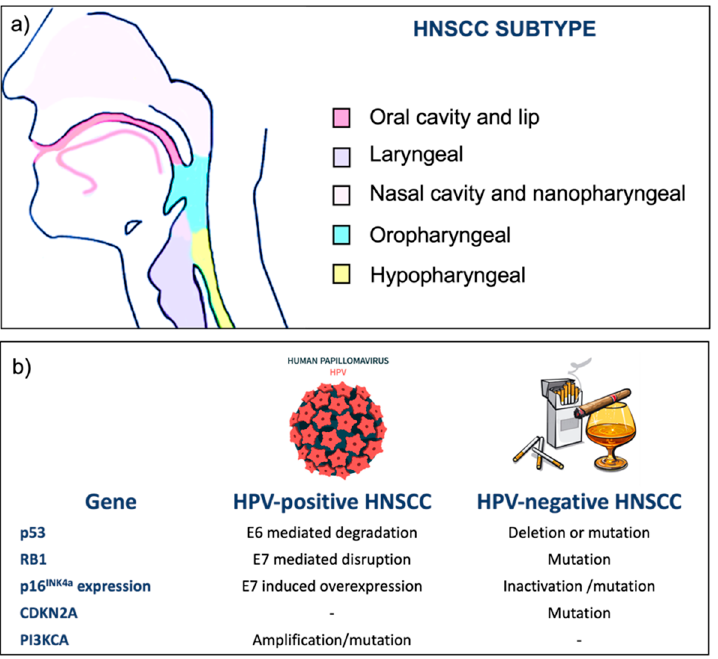
Figure 1. ( a ) Anatomical sites of HNSCC subtype; ( b ) main genetic differences between HPV-positive and HPV-negative HNSCCs.